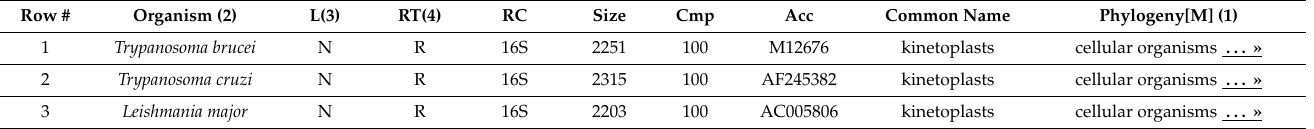
Table 1. The three selected Trypanosoma brucei , Trypanosoma cruzi , and Leishmania major sequences selected for this study. L(3) refers to the cell location, which is the nucleus, RT(4) refers to RNA type R = ribosomal RNA (rRNA), RC refers to the RNA Class 16S, Nucleotide size, Cmp means % Complete , Acc means gene bank accession number, common name and the Phylogenetic Classification, m.